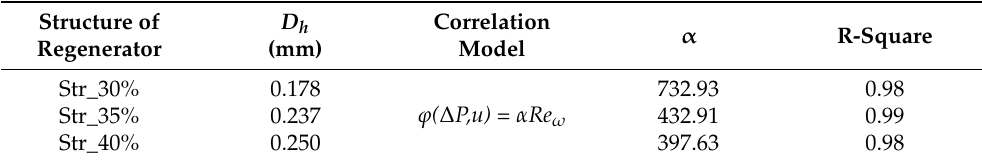
Table 3. Phase shift correlations between the pressure drop and speed for different regenerator structure.